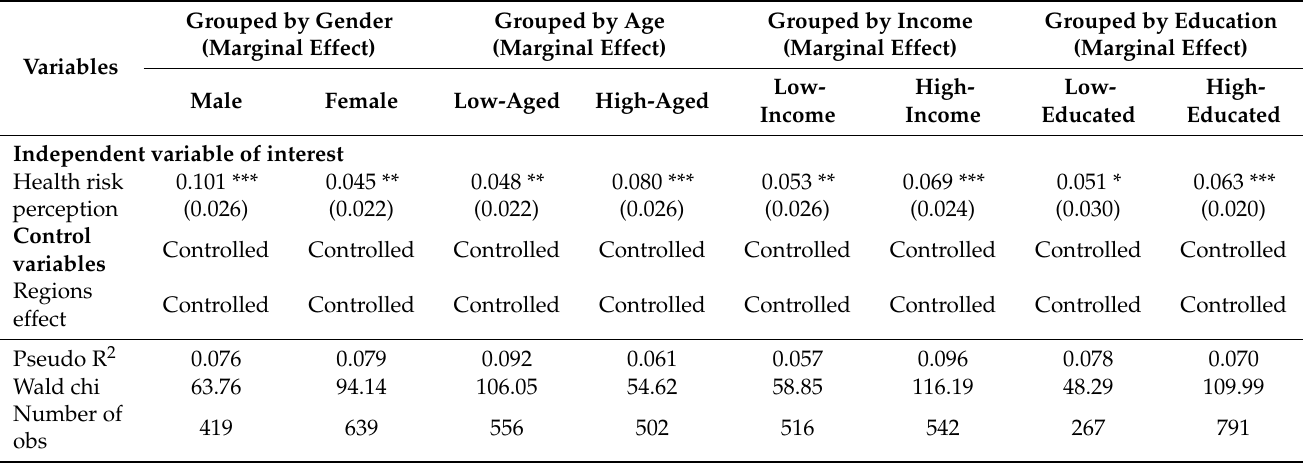
Table 3. Results of Heterogeneity